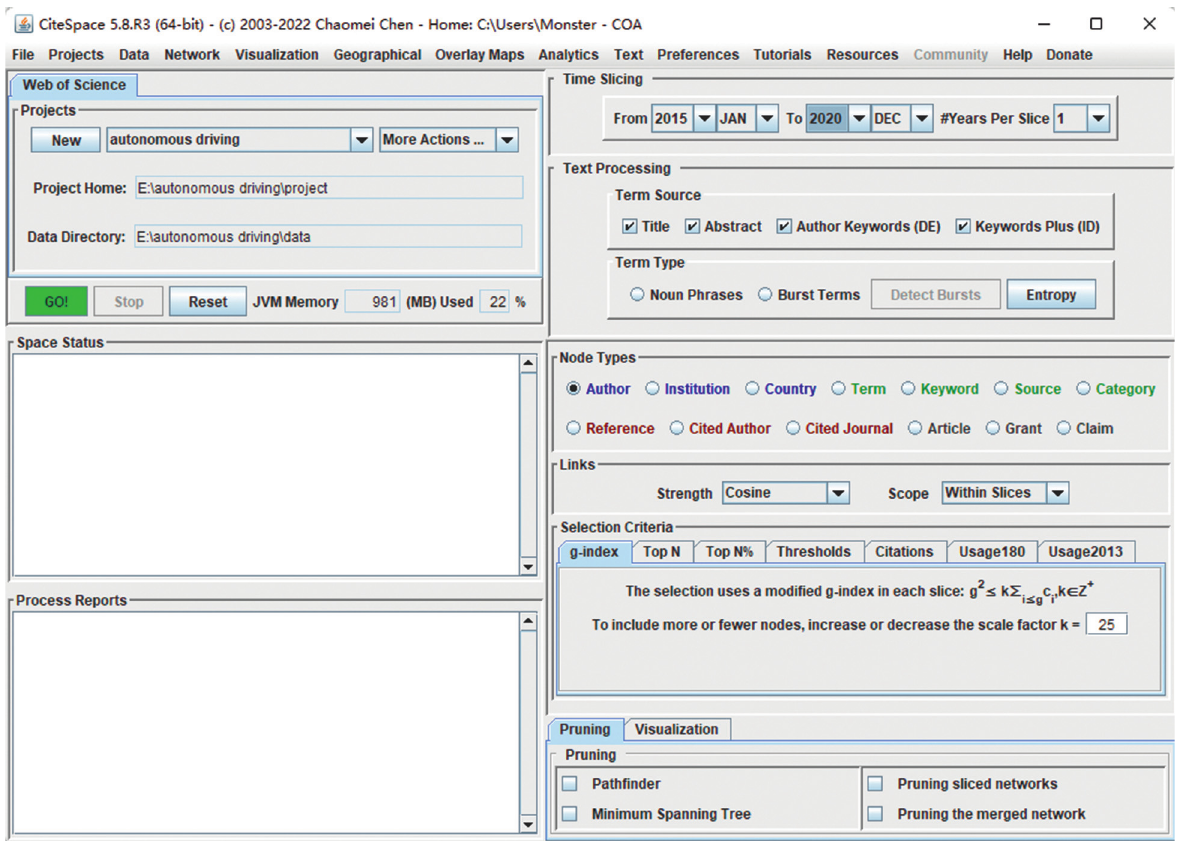
Figure 1: An example screen of